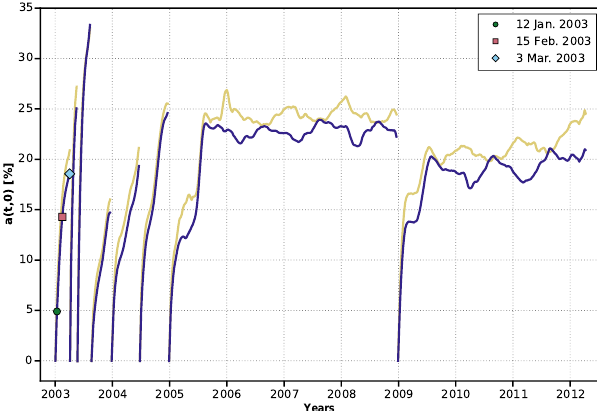
Figure 5. Zero-order radiometric offset over time retrieved from cloud-free high albedo SCIAMACHY spectra above the Sahara re- gion (dark blue) and above Australia (yellow). The offset is given in percentage of the mean signal of the spectra and data gaps are interpolated. The three example orbits of Fig. 4 are